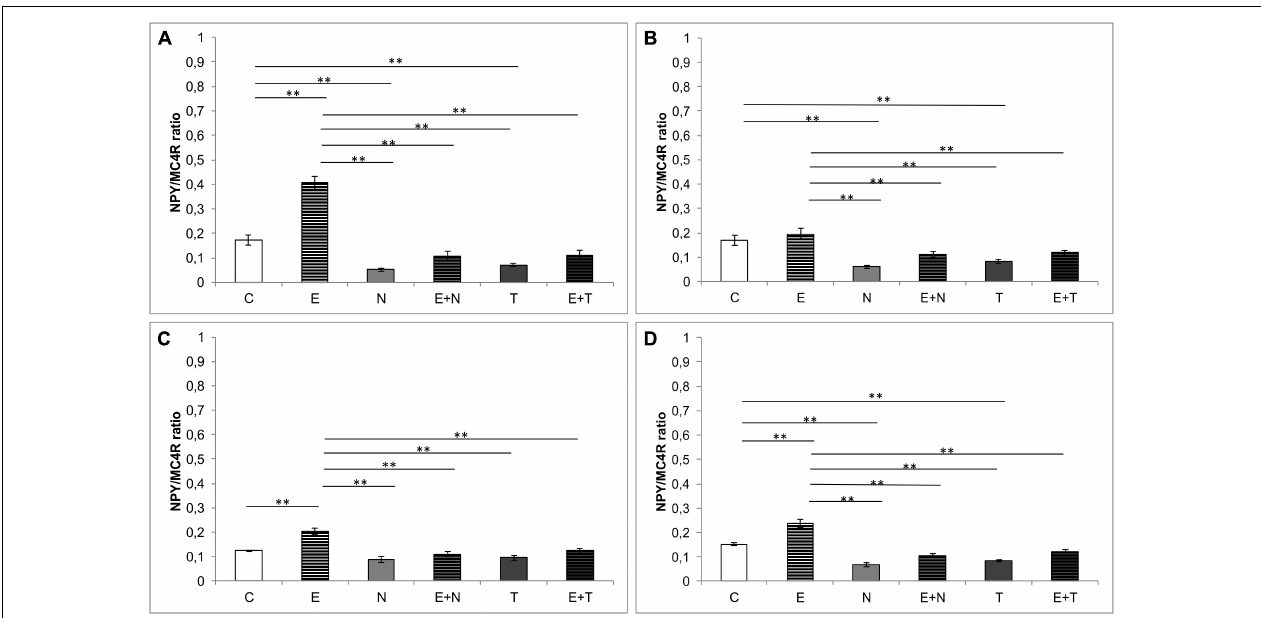
FIGURE 5 | NPY/MC4 ratio in hippocampal regions. (A) CA1 region, (B) CA2/3 region, (C) DG, (D) per hippocampal section; (C, control group; E, exercise group; N, nandrolone-decanoate group; E+N, exercise plus nandrolone-decanoate group; T, testosterone-enanthate group; E+T, exercise plus testosterone-enanthate group). Bars represent means ± SEM, ∗ denotes a significant difference p ≤ 0.025, ∗∗ denotes significant difference p ≤